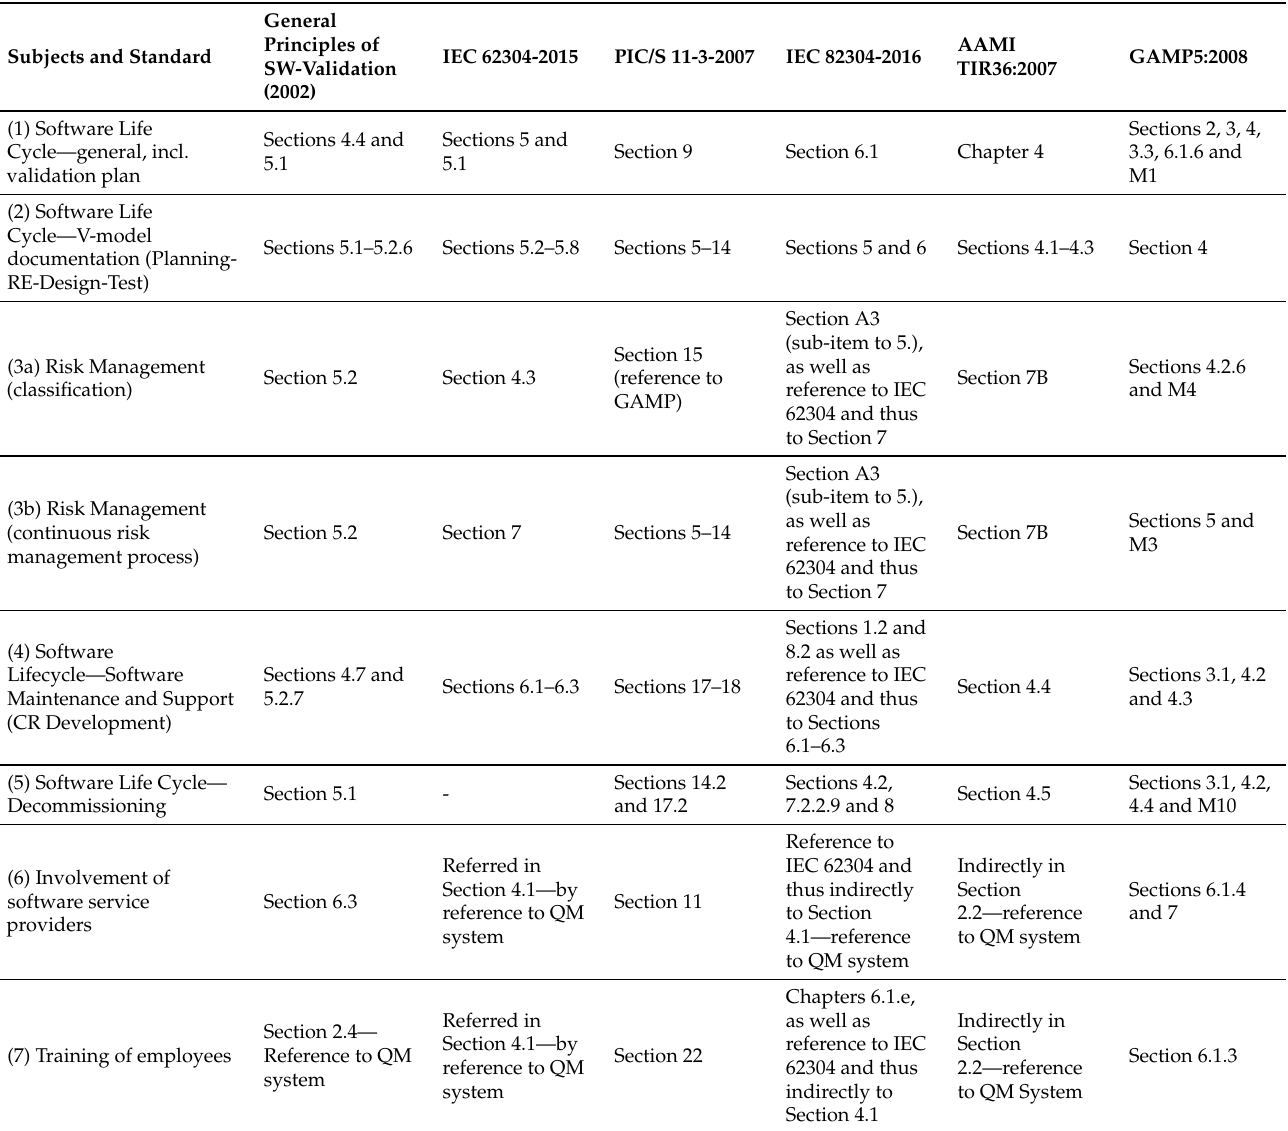
Table 1. Overview of relevant regulatory